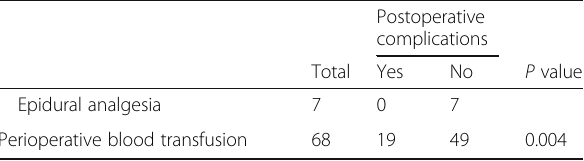
Table 1 Characteristics of orthopedic surgery patients in this study (Continued)